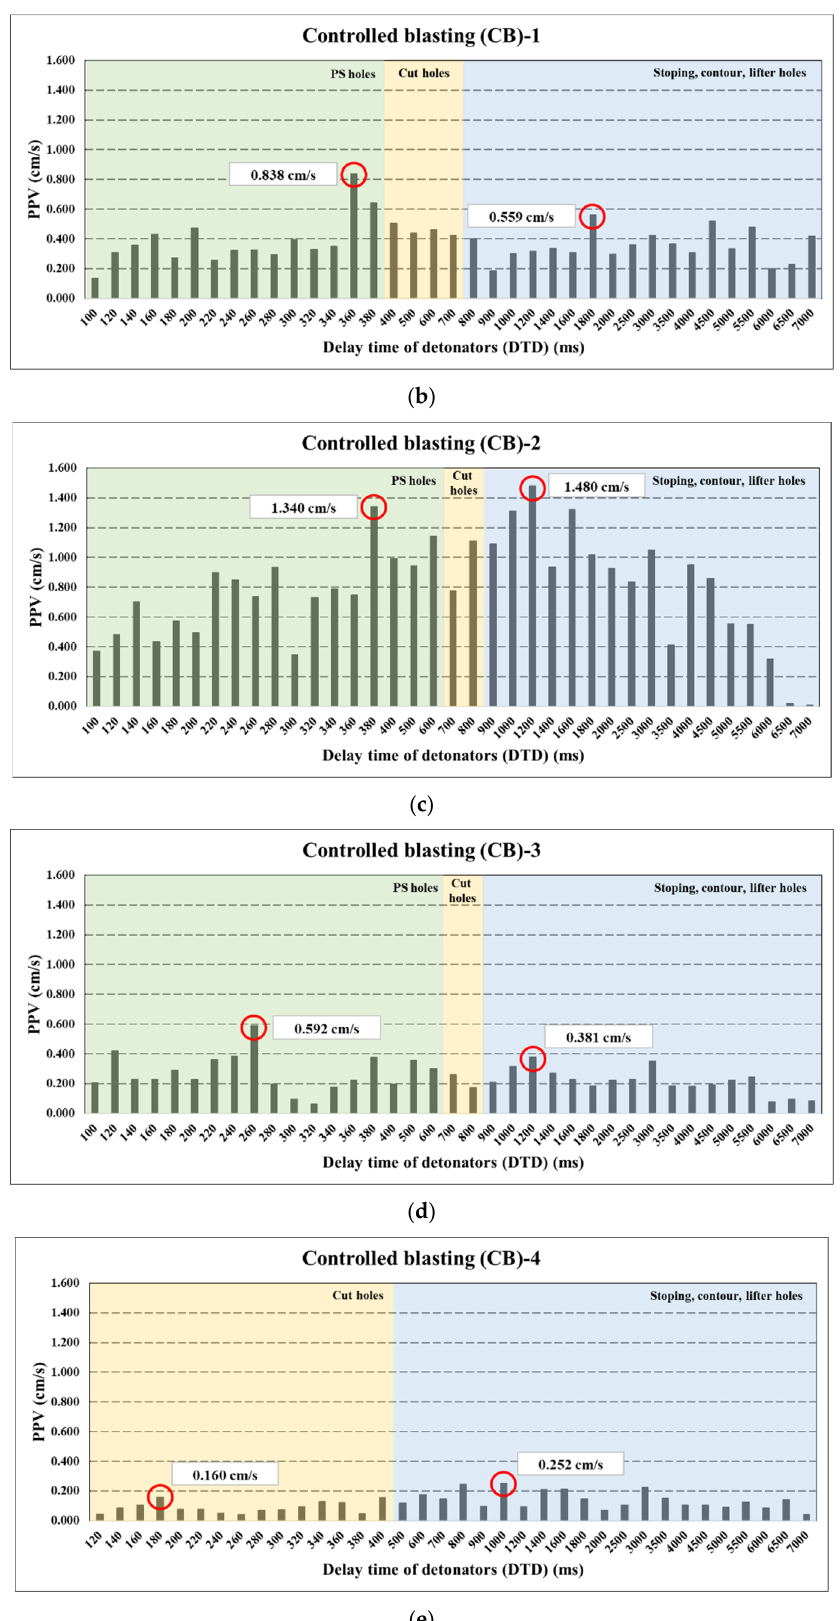
Figure 9. Histories of blast-induced vibration according to detonation delay time for: ( a ) B, ( b ) CB-1, ( c ) CB-2, ( d ) CB-3, and ( e ) CB-4.